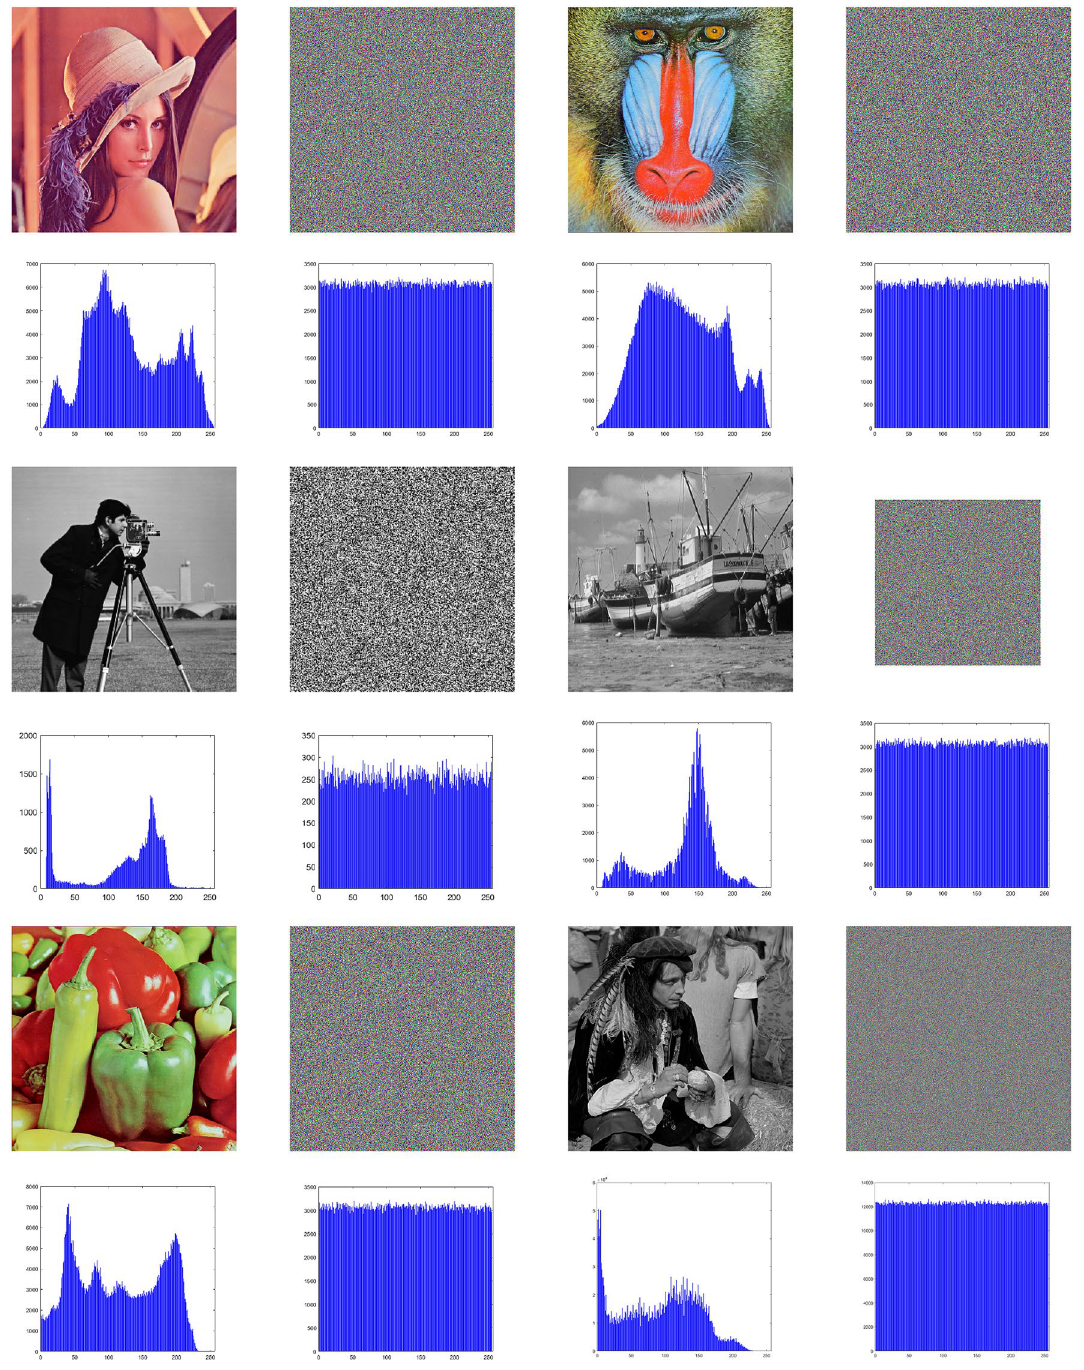
Fig. 13 Histogram